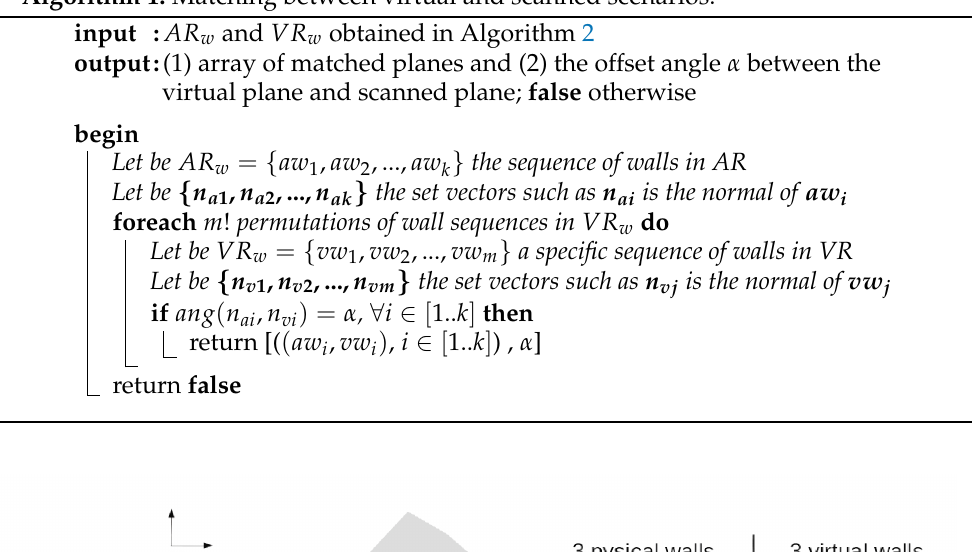
Algorithm 1: Matching between virtual and scanned scenarios.